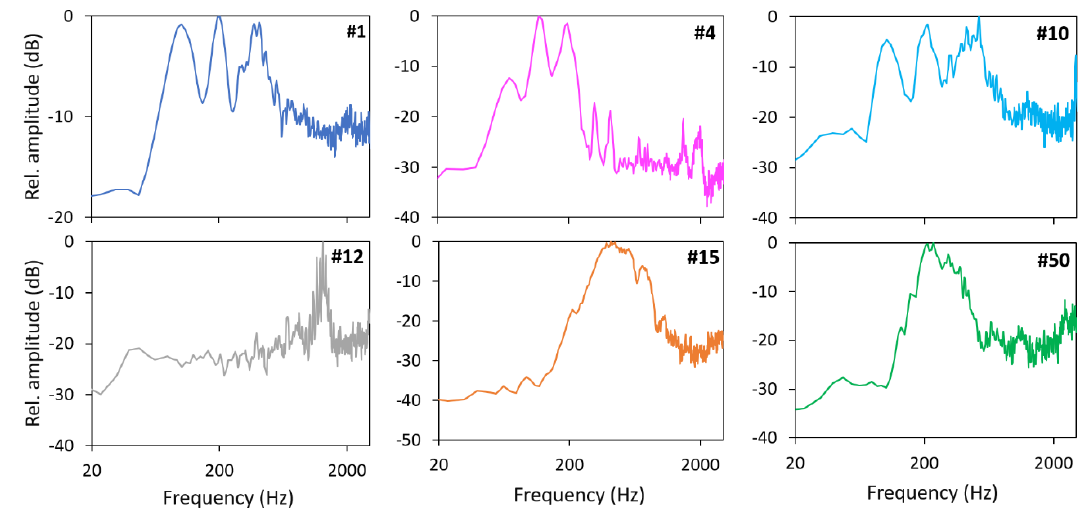
Figure 6. Power spectra for the best example of six common fish sound sequences manually identified from recordings. Spectra settings: sampling frequency: 8 kHz; FFT size: 1024; window type: Hanning, 50% overlap.